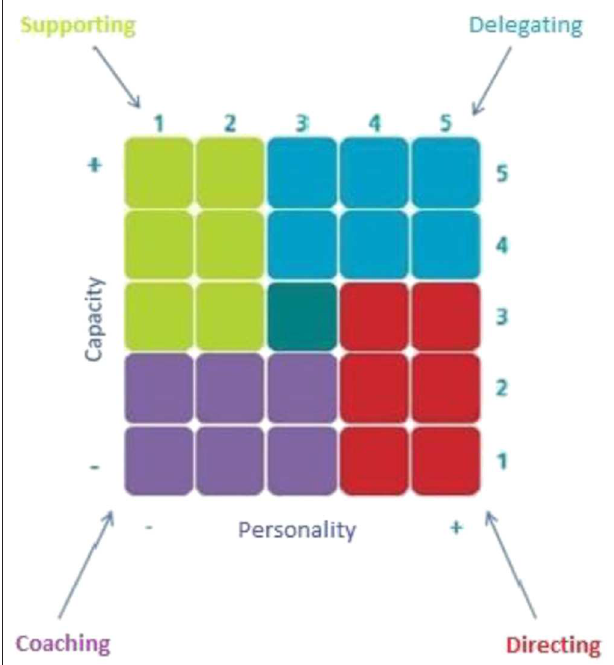
FIGURE 3 | Optimal guidance styles as a function of personality and capacity scores, according to AMN (2014). Coaching: these participants should be guided on both the task as well as on the relationship. Supporting: these participants should be guided on mainly the relationship, less on the task. Delegating: these participants need little guidance on both the task and the relationship. Directing: these participants should be guided on mainly the task, less on the